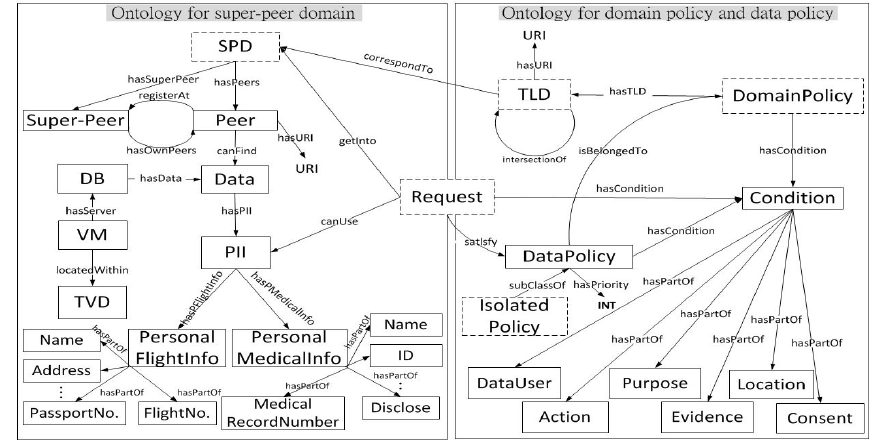
Figure 2. The semantics of a super-peer data cloud is described as the policy ontology, which includes two modular concepts ( a ) SPD; ( b ) domain and data policy. An SPD domain includes a super-peer and various peers. A domain policy first decides whether a data request is permitted to enter a TLD. Then, a data policy is used for querying data from the